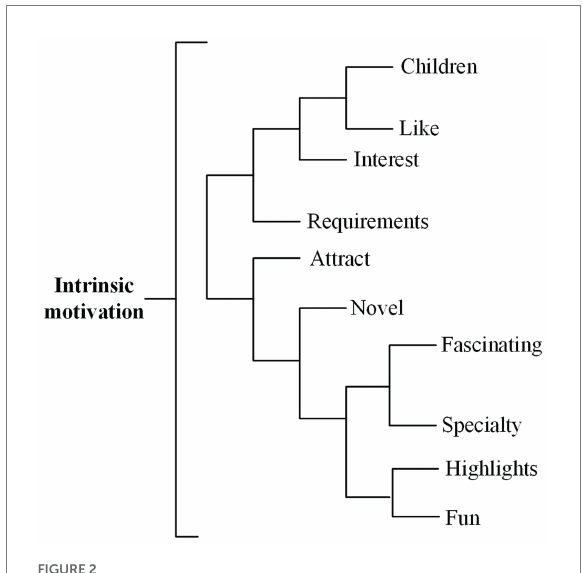
FIGURE 2 Intrinsic motivation dimension